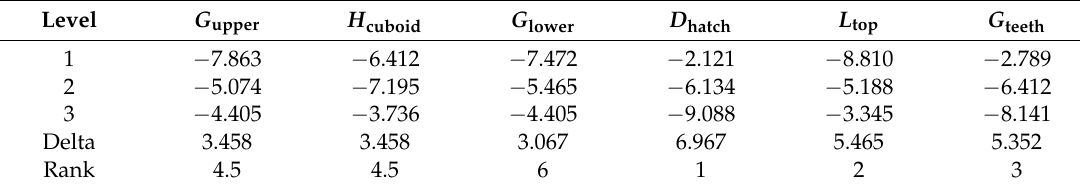
Table 5. Average S / N ratio for warp.